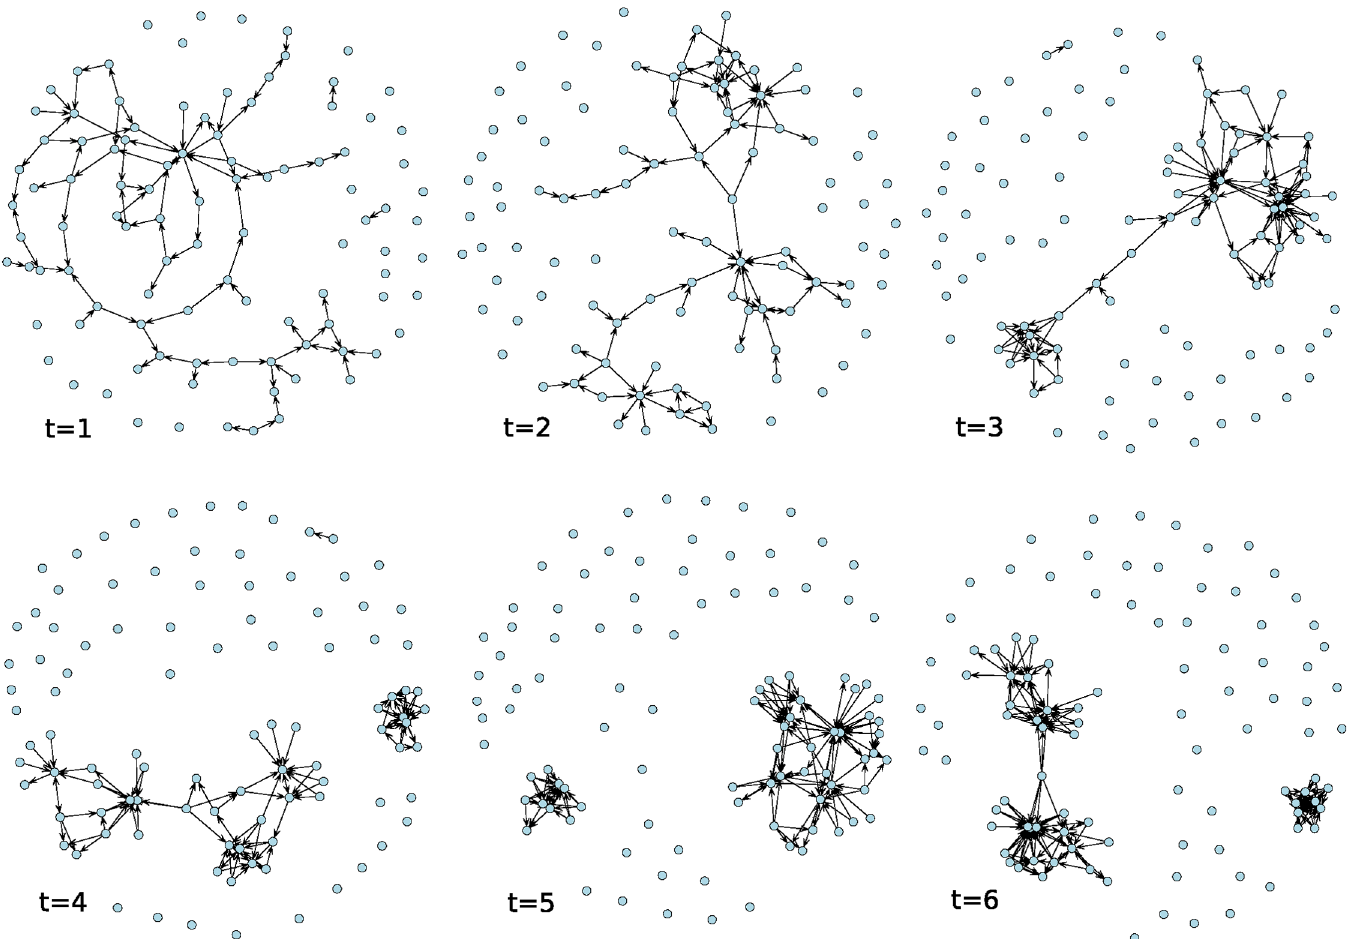
Fig 2. Evolution of social influence on a random graph with n = 100 nodes and graph density of 0.01. Patterns of influence among individuals (nodes) over time represented as networks in which a tie denotes the presence and direction of social influence between two individuals at a particular time.